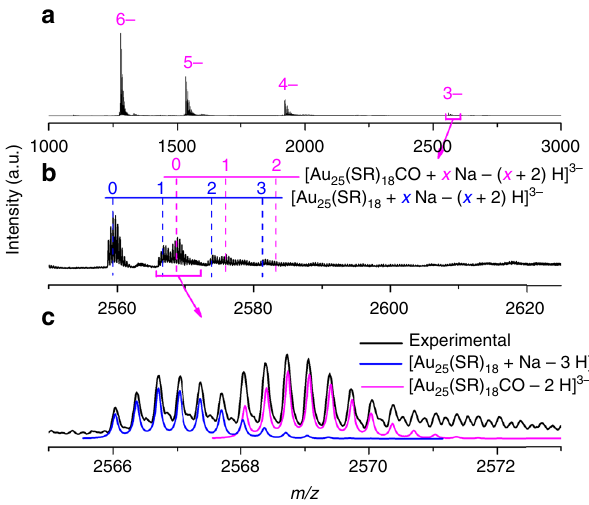
Fig. 6 Capture of [Au 25 (SR) 18 CO] − intermediate. Electrospray ionization mass spectra of the CO-saturated [Au 25 (SR) 18 ] − aqueous solution in a large m/z range of 1000 – 3000, b zoom-in m/z range of 2550 – 2625, and c isotope resolution. The dotted drop-lines in b are visual guides for [Au 25 (SR) 18 ] − (blue lines) and [Au 25 (SR) 18 CO] − (magenta lines) associated with varied numbers of Na + . The blue and magenta lines in c are simulated isotope patterns of [Au 25 (SR) 18 +Na – 3 H] 3 − and [Au 25 (SR) 18 CO – 2 H] 3 − , respectively. The CO-saturated [Au 25 (SR) 18 ]